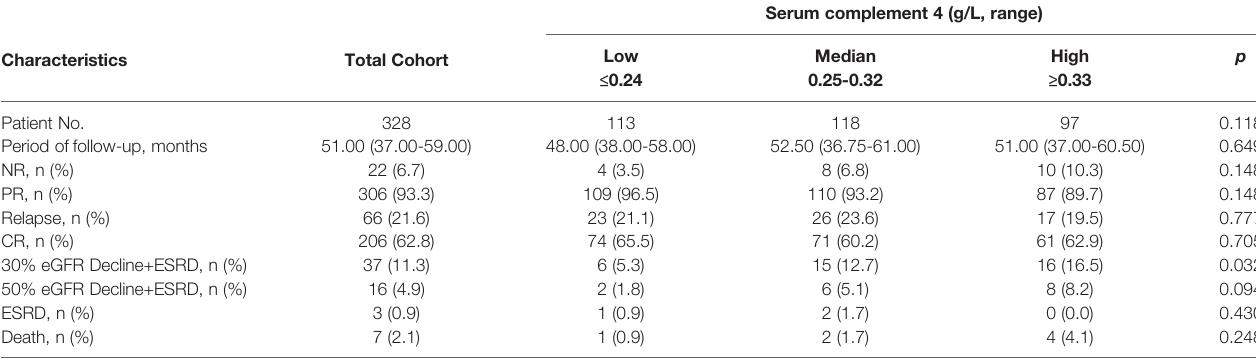
TABLE 2 | Associations of serum complement 4 with IMN outcomes.